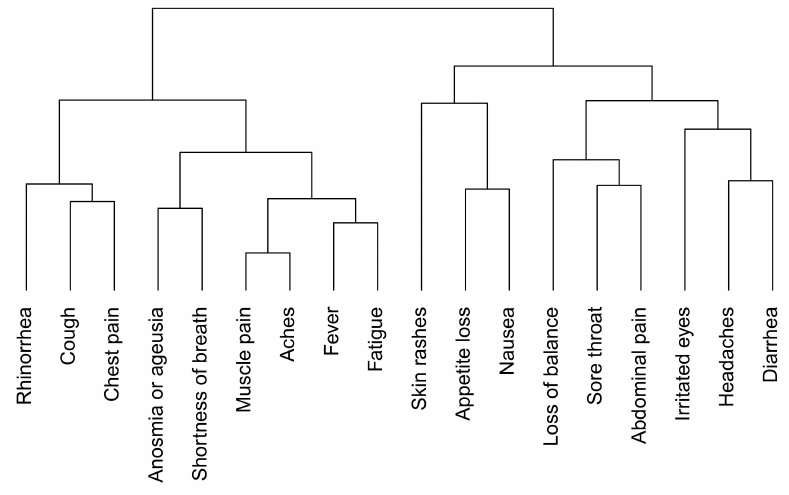
Figure 3. Dendogram of symptoms in seropositive individuals ( n = 43). Among those with at least one symptom, many (72%) reported this symptom as “intense”. A cluster analysis of symptoms in SARS-CoV-2–positive individuals grouped anosmia or ageusia with influenza-like illness (Figure 4). Anosmia or ageusia was strongly associated with shortness of breath ( p = 0.0002) and fever ( p = 0.0008) but almost never occurred without fever (1/17).